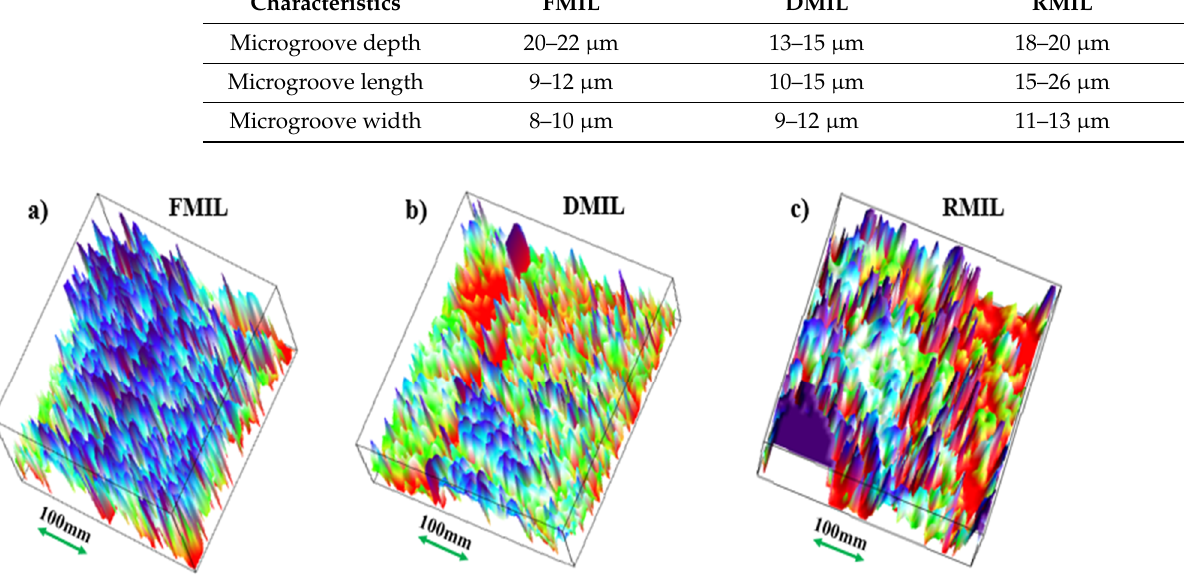
Table 2. Characteristics of functional surfaces.